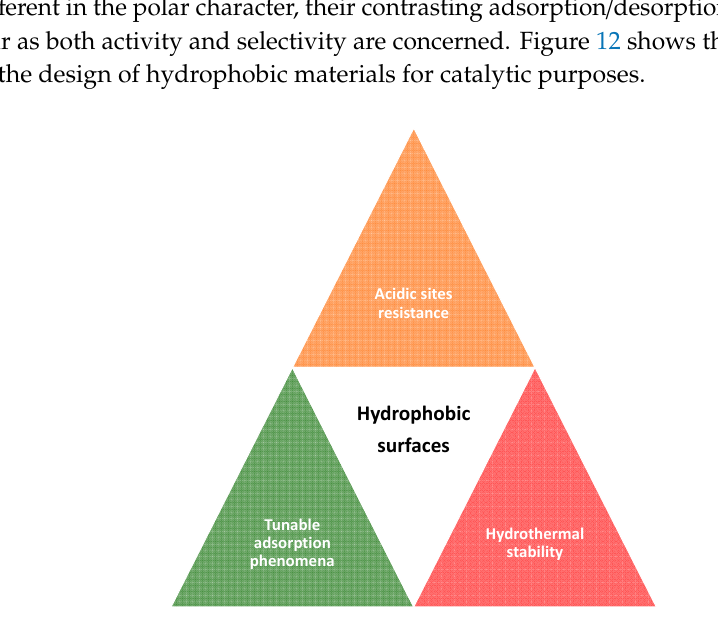
Figure 12. Main e ff ects on catalysis obtained by designing proper hydrophobic Figure 12. Main effects on catalysis obtained by designing proper hydrophobic materials. the relationship between hydrophilicity/hydrophobicity and catalyst stability in terms of both acidity and hydrothermal properties.